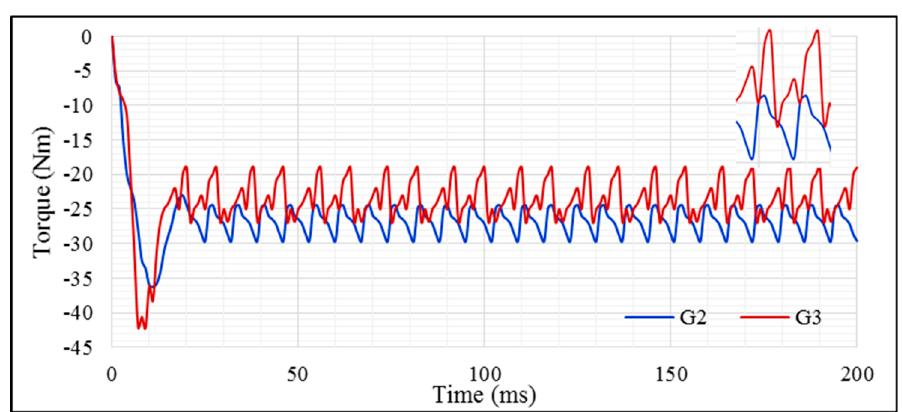
Figure 14. Electromagnetic torque during generating mode for G2 and G3 (operating at rated load).